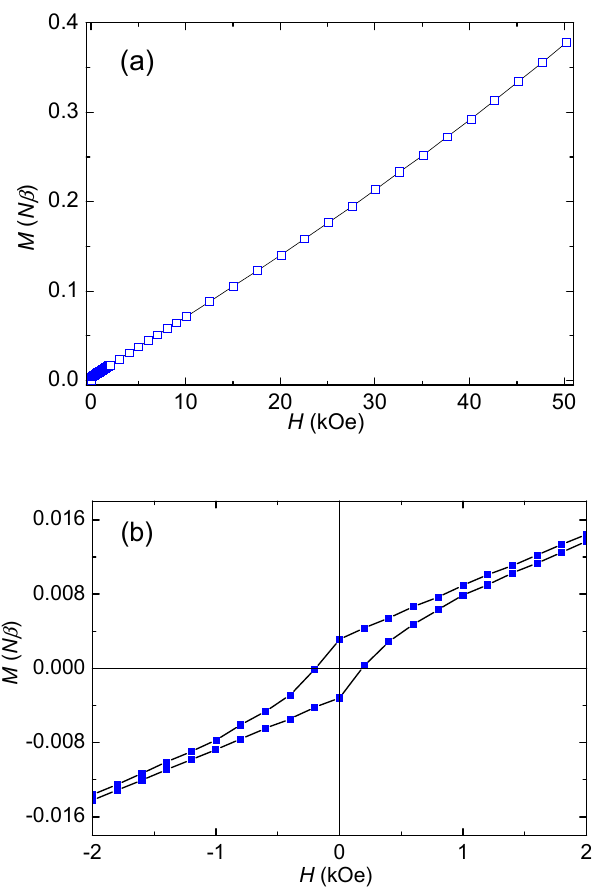
Figure 9. ( a ) Field-dependent magnetization of compound 1 at 2.0 K and ( b ) the blow-up of the hysteresis loop.